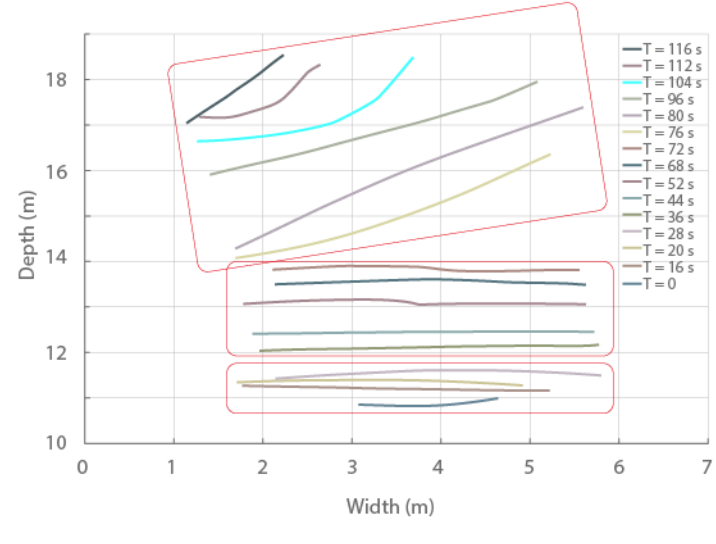
Figure 33. Temporal evolution of the fire position for the whole spread.